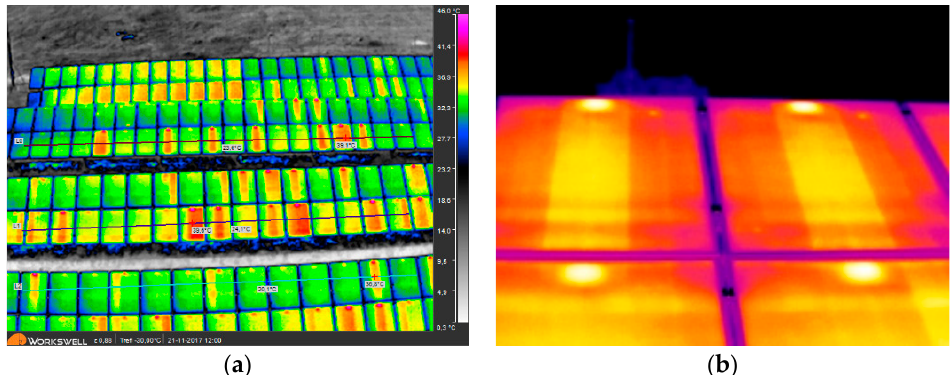
Figure 12. Thermographic analysis with an incident of PV modules with open-circuit substrings: ( a ) aerial IR inspection, and ( b ) ground-level IR inspection.